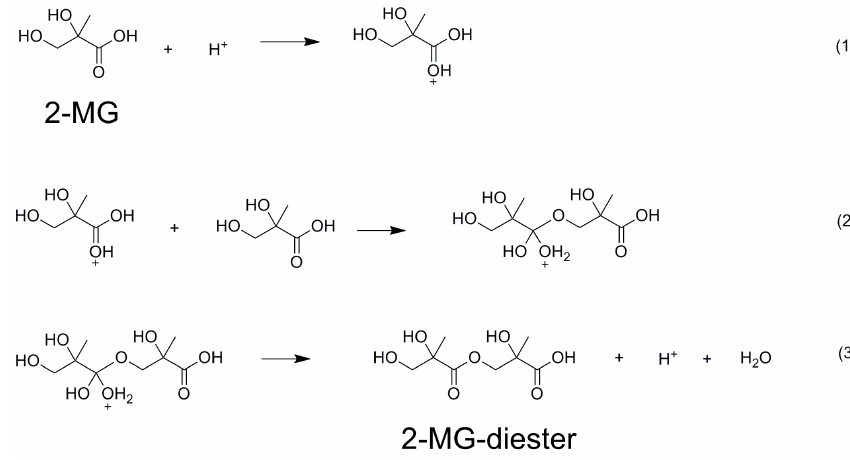
Fig. 1. Postulated Fischer esterification mechanism for 2-MG oligoester formation.